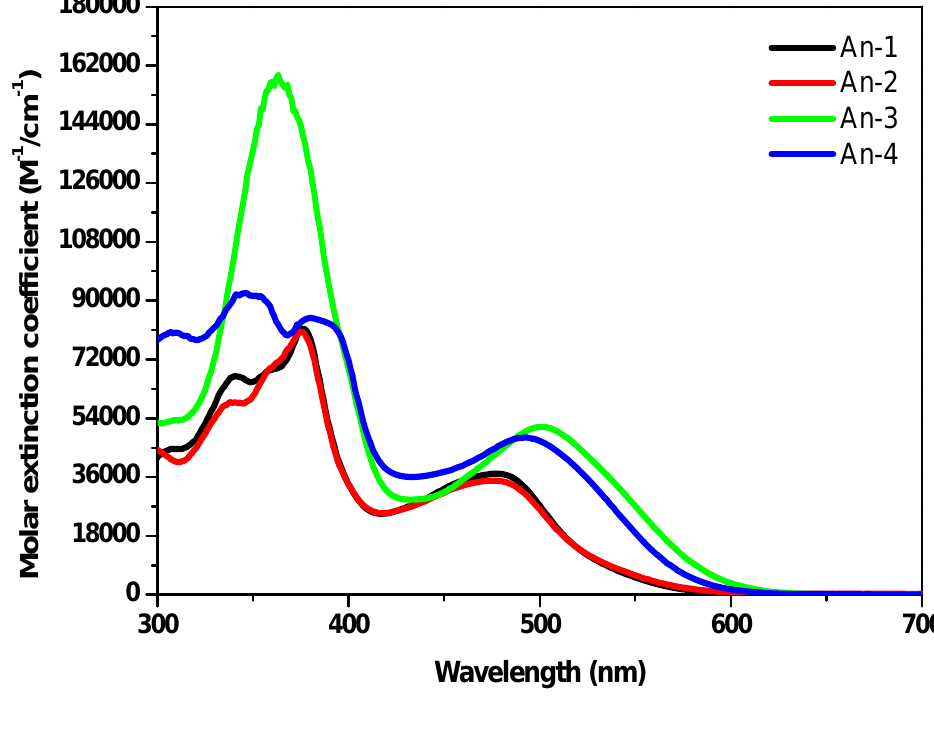
Figure 1. Absorption spectra of the dyes in THF